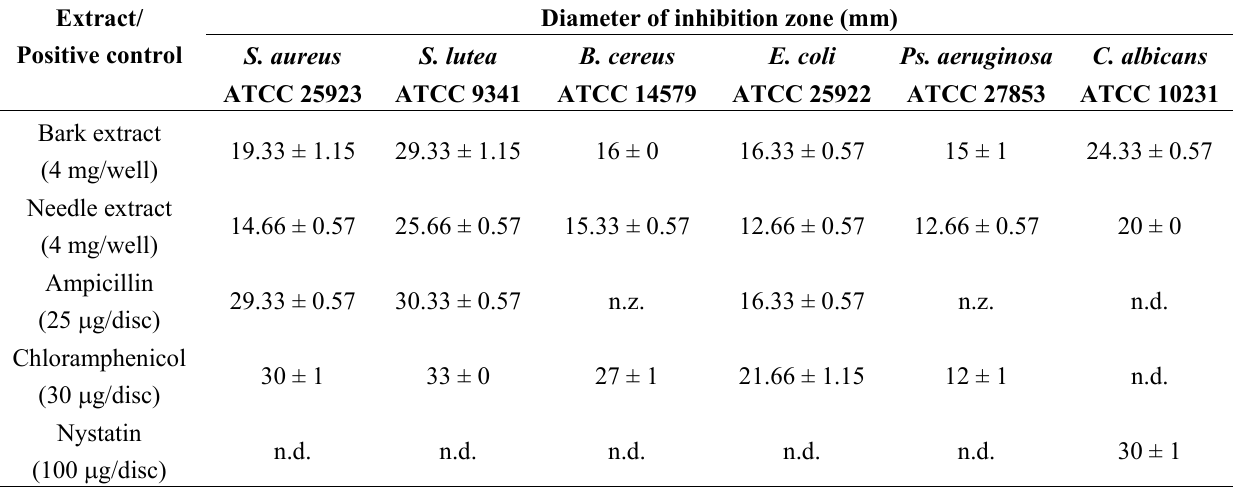
Table 3. Antimicrobial effects of Pinus cembra L.